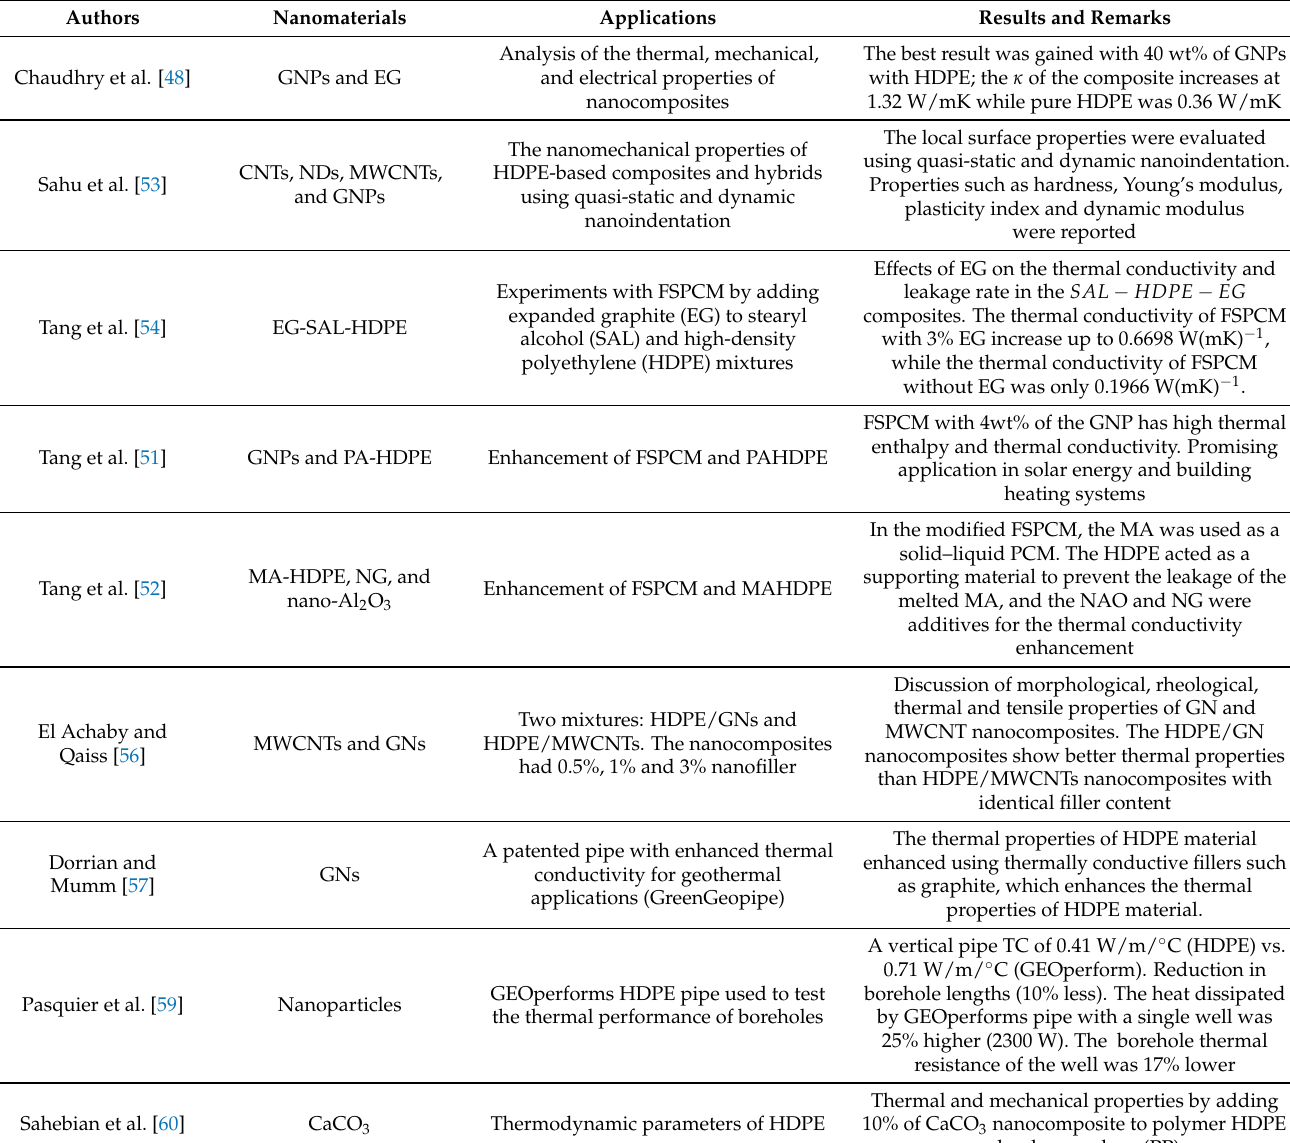
Table 5. Summary of experimental studies on heat exchanger pipes using